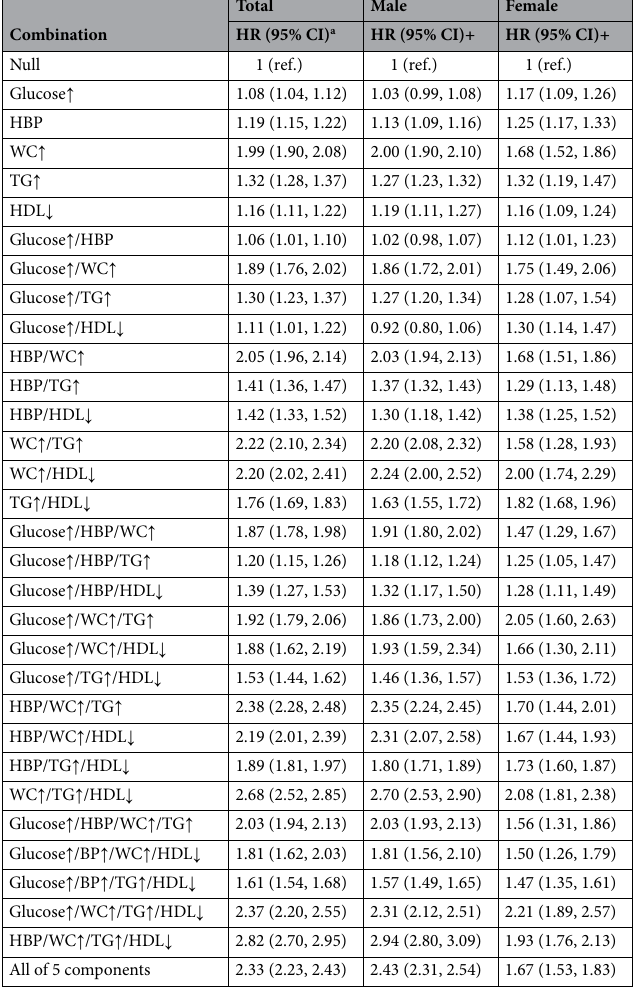
Table 3. Incidence rates and HRs of OSAS according to the presence of a combination of MetS components (for the period 2009–2018). a Adjusted for age, sex, smoking status, alcohol consumption, regular exercise, and body mass